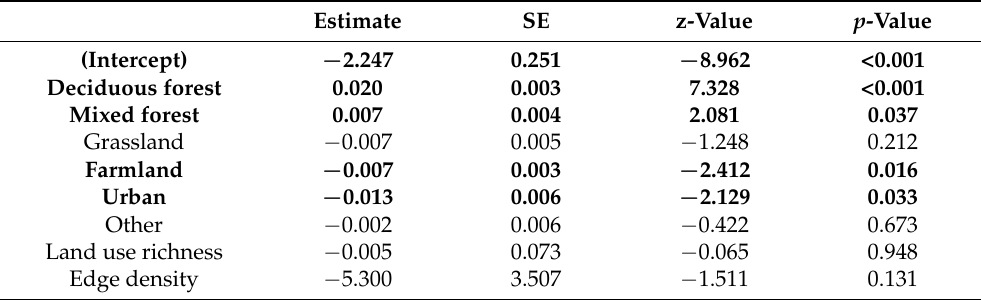
Table 3. GLM model results accounting for the presence and absence of species stock dove ( Columba oenas ) concerning different land use types, land use richness, and edge density in 2016. Abbreviations: SE—standard error. Significant variables are highlighted in bold.